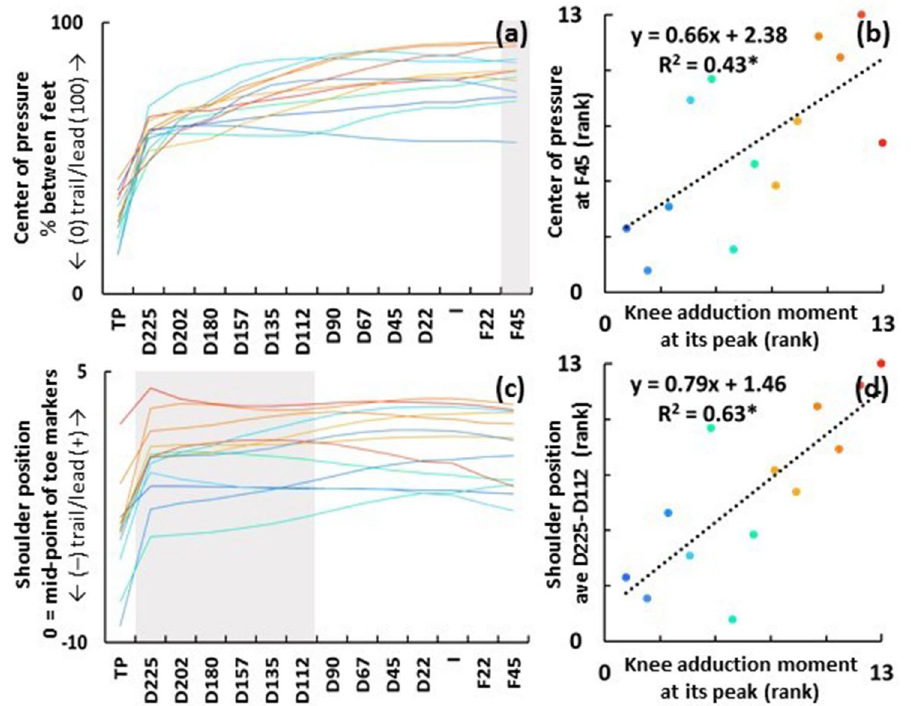
Figure 4. Center of pressure and shoulder positions during the downswing are displayed in the graphs ( a ) and ( c ), respectively. The gray areas represent the swing events that showed a significant correlation with the peak knee adduction moment of the lead leg in SPM regression analysis. Each line represents the mean trajectories of each participant over 5 shots. The gradation of colors in warm and cool represent the high and low knee adduction moment of the lead leg at its peak, respectively. The horizontal axes show 14 sequential downswing events (see Fig. 1). Graph ( b ) and ( d ) represent the Spearman correlations between the rank of peak knee adduction moment of the lead leg and center of pressure and shoulder positions (the rank of mean value averaged across the events showed a significant correlation in SPM regression), respectively. Direction of towards-target center of pressure position with respect to the trail foot (0%) has a positive value of maximum at lead foot (100%). Directions of towards-target shoulder position with respect to the mid-point of toe markers have a positive value. F45: follow-through 45°, D225: downswing 225°, D112: downswing 112°. *significant at p <